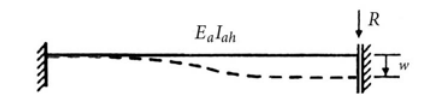
Fig. 6. Beam rotationally fixed at both ends under concentrated load at one of its